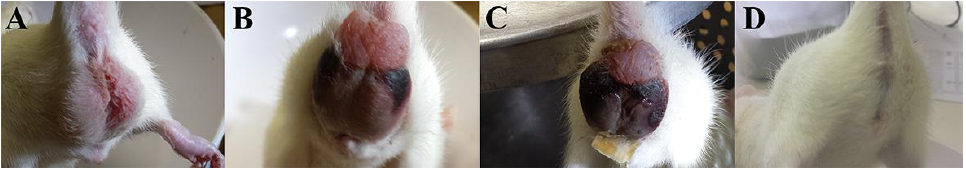
Figure 4. Macroscopic aspect of the scrotum of Wistar rats from ( A ) AC group (testicles exposed to the external AC magnetic field only) 7 days post-treatment, ( B ) MNH group (testicles injected with magnetic fluid and exposed to the external AC magnetic field) 4 days post-treatment, ( C ) MNH Group 15 days post-treatment, and ( D ) MNH Group 56 days post-treatment.